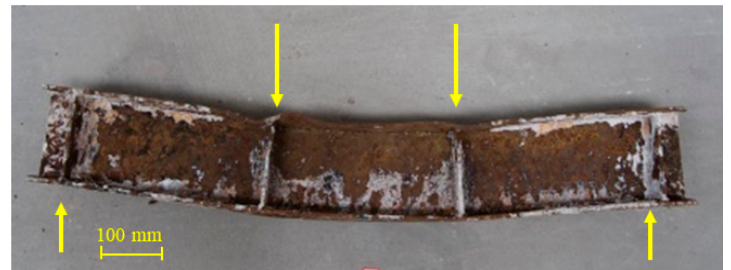
Figure 10. Failure diagram of corroded beam GC ‐ 180 ‐ 6.